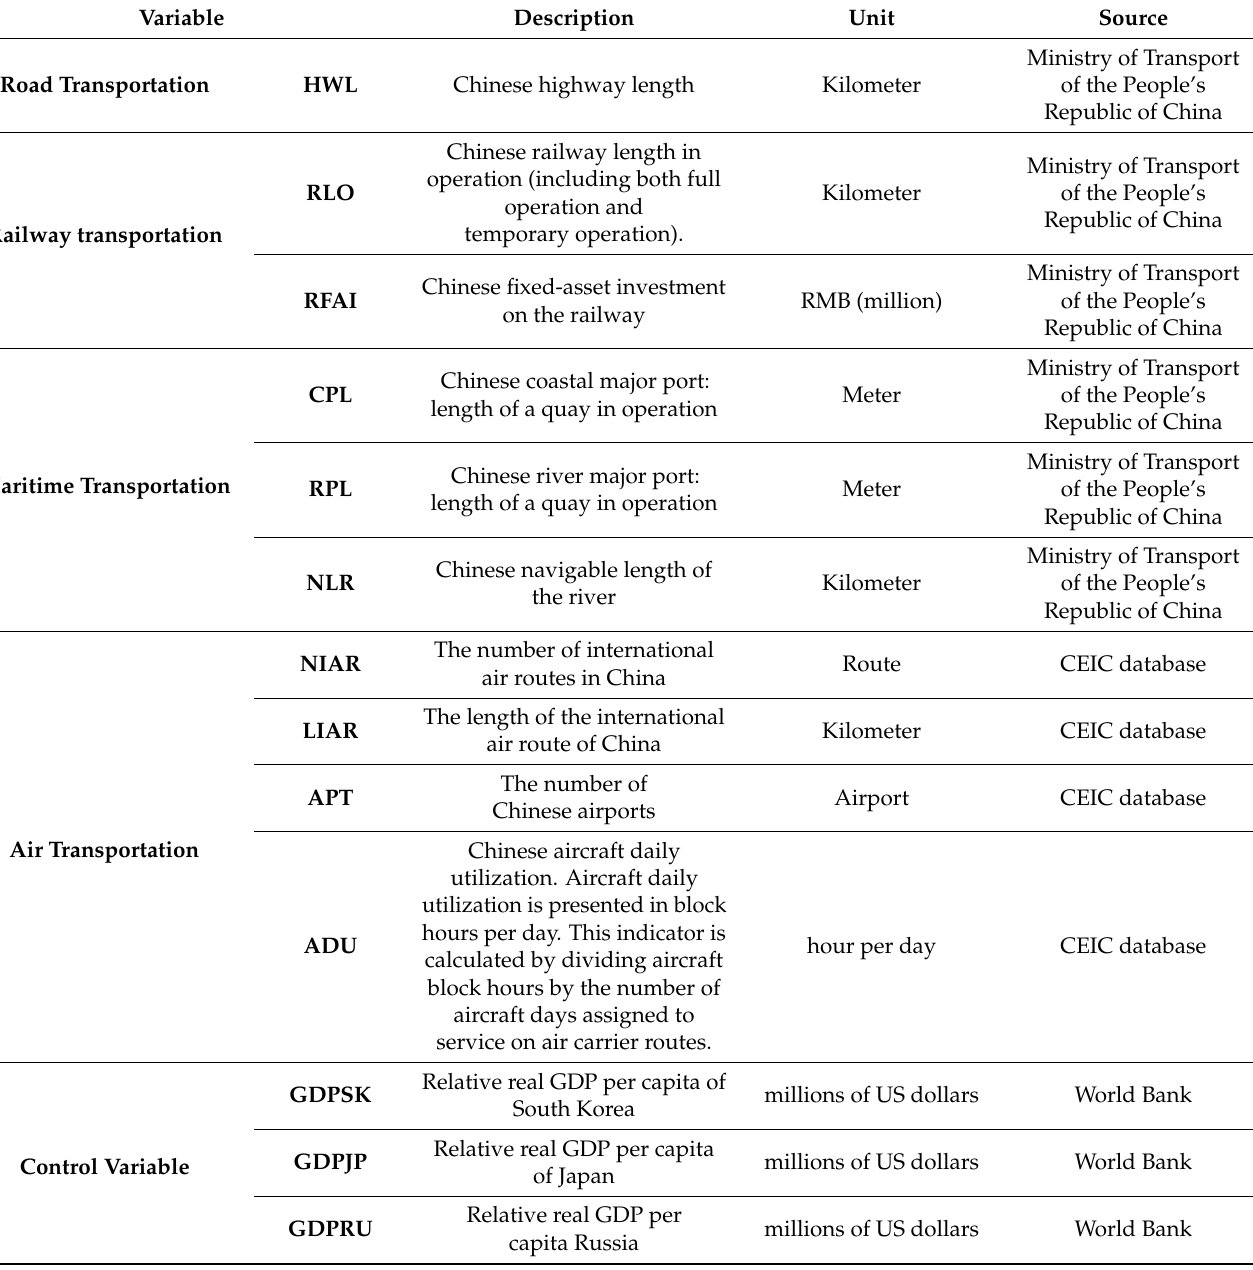
Table A1. Variable description and